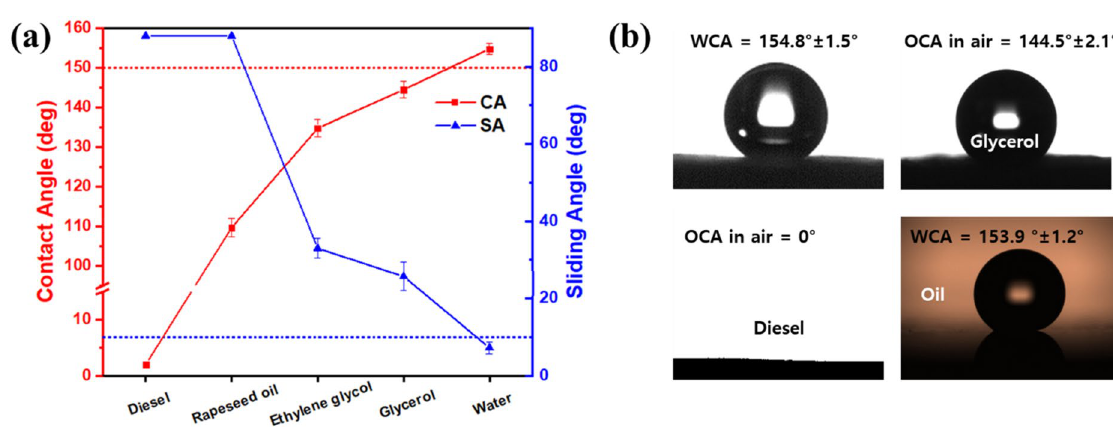
Figure 3. ( a ) CAs and SAs of liquid droplet in air as a function of surface tension. ( b ) Typical CA measurements of modified GMF membrane. OCA oil contact ured the pressure exerted by the mixture on the GMF membrane. The oil passes through the separation device while water is blocked by the membrane and discharged through the valve. Figure 5a displays the separation efficiency of the modified GMF membrane for different light oil/water mix- tures (diesel, decane, hexane, and lubricant oil). High separation efficiency ranging from 99.95 to 99.90% was observed for each oil/water mixture, with the water content in the separated oil ranging from 100.7 to 202.2 ppm. Moreover, separation experiments were performed with a heavy oil/water mixture. Supplementary Fig. S4 shows